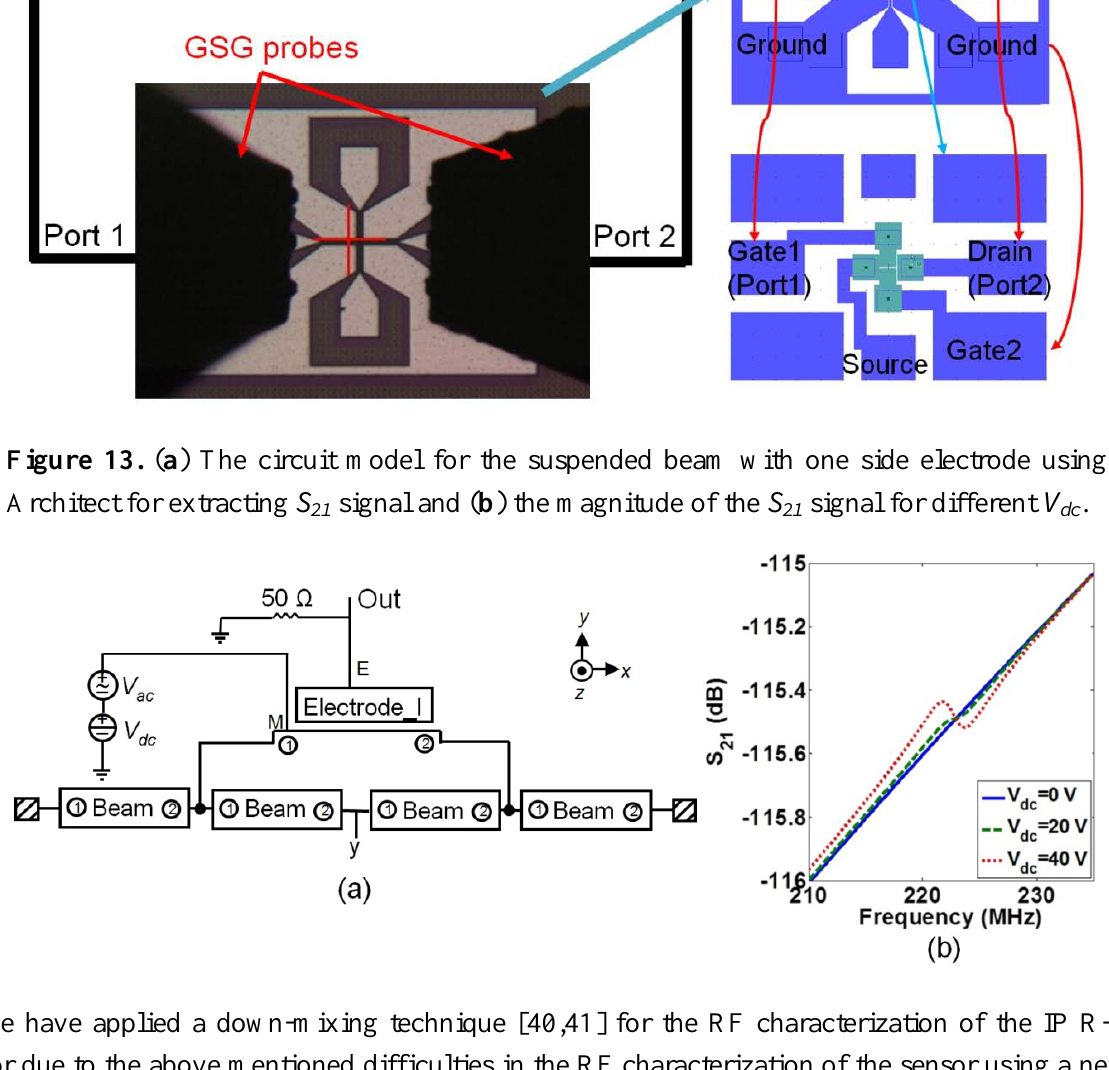
Figure 12. The radio frequency (RF) measurement setup for the in-plane resonant nano-electro-mechanical (IP R-NEM) sensor.